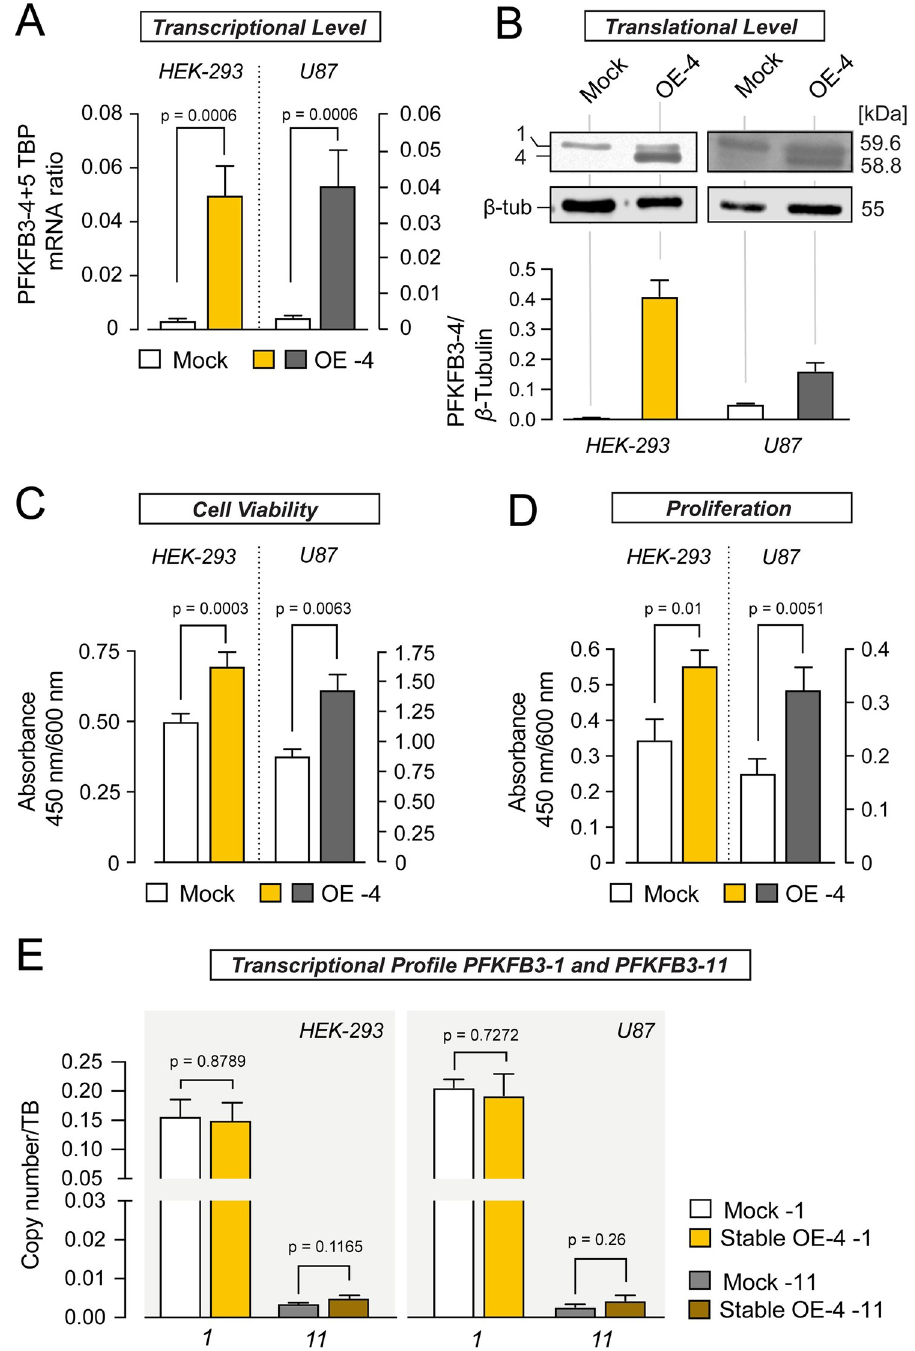
Fig 4. PFKFB3-4 overexpression facilitates cell viability and proliferation. (A) Quantification of PFKFB3-4+5 mRNA levels from HEK-293 (yellow) and U87 cells (grey) stably overexpressing PFKFB3-4 (OE -4), respectively. mRNA-measurement was done with 4 independent experiments (N = 4, n = 1–2). PFKFB3-4 mRNA quantity measured by quantitative PCR was normalized to the amount of TBP mRNA and compared to mock samples. (B) Western blot analysis to confirm the overexpression of PFKFB3-4 with polyclonal PFKFB3 antibody. β -Tubulin served as loading control, 10 μ g protein was loaded per lane. 1 refers to PFKFB3-1 and 4 refers to PFKFB3-4. The ratio of protein bands (PFKFB3-4 to β -Tubulin) was calculated from the intensity values of protein bands (n = 3). (C) Effect of stable PFKFB3-4 overexpression on cell viability, measured by WST-1 assay. After a 4 h incubation period with WST-1 reagent the absorbance was measured at 450 nm/600 nm. WST-test was done in 4–5 independent experiments in